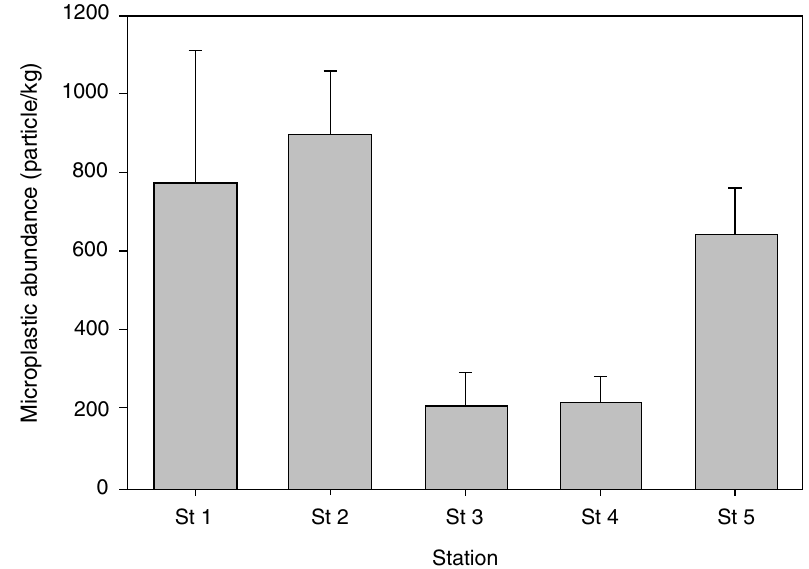
Figure 2. The abundance of microplastics in each sampling site